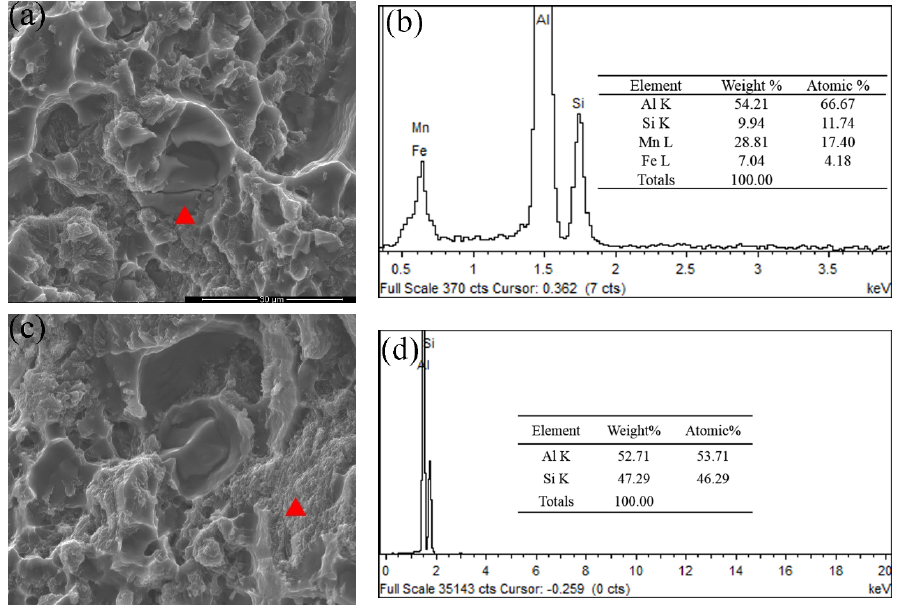
Figure 7. SEM fractography of the as-cast alloys. ( a ) The fracture surface containing α -Fe phases, ( b ) EDS analysis results of α -Fe phases, ( c ) the fracture surface containing eutectic Si particles, ( d ) EDS analysis results of eutectic Si regions.